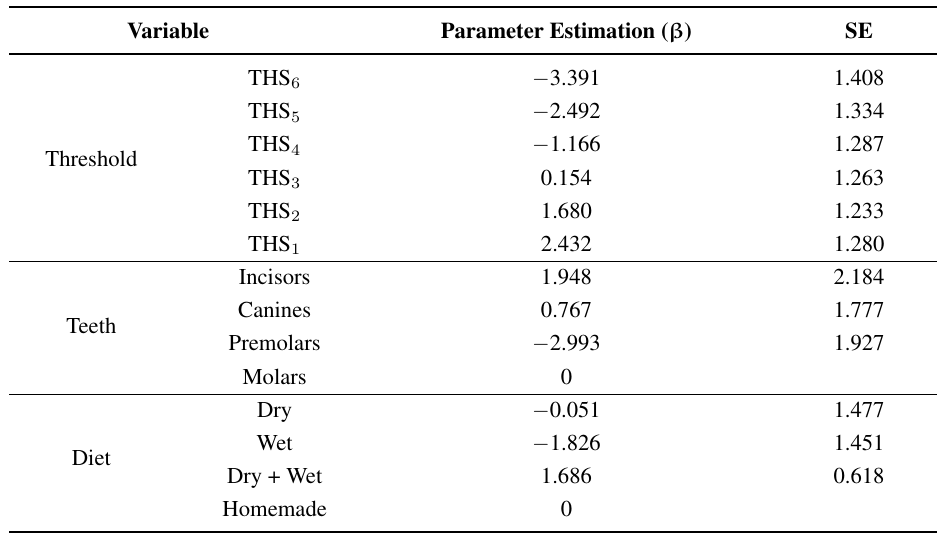
Table 1. Parameters estimation for the equations used to calculate the probability of each of the combinations of teeth type, diet, and age, to score each of the THS